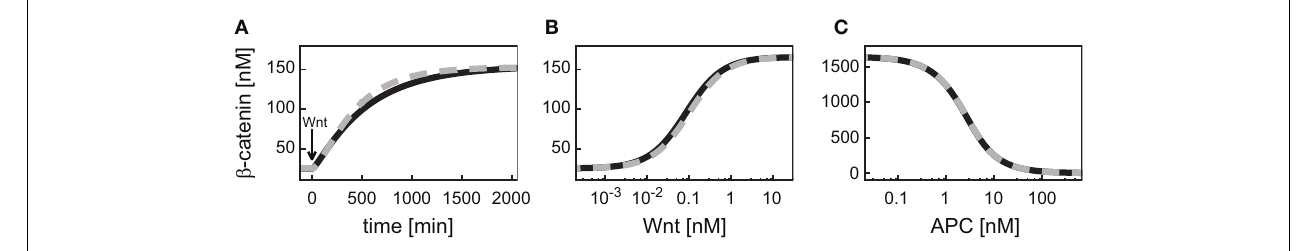
levels ofWnt or APC, respectively, within corresponding concentration gradients.The simulations of the minimal (black, solid line) and the detailed model (gray, dashed line) are compared.